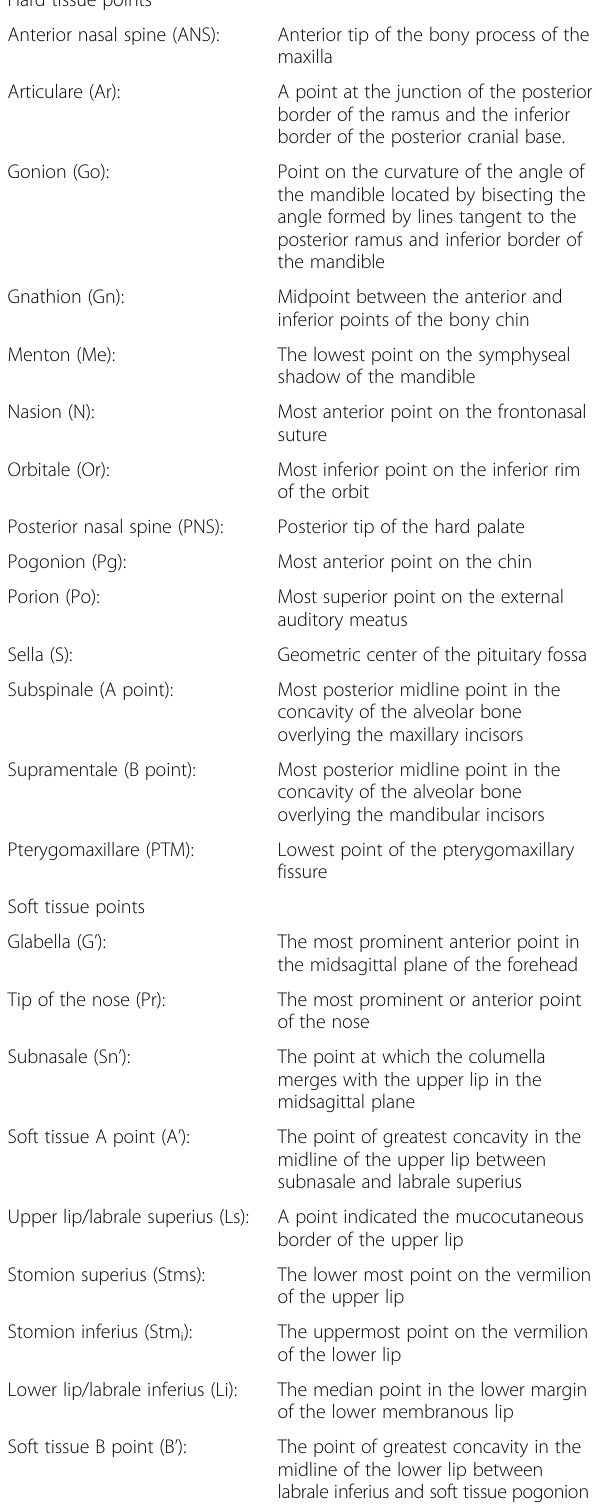
Table 1 Description of cephalometric landmarks used in this study Hard tissue points